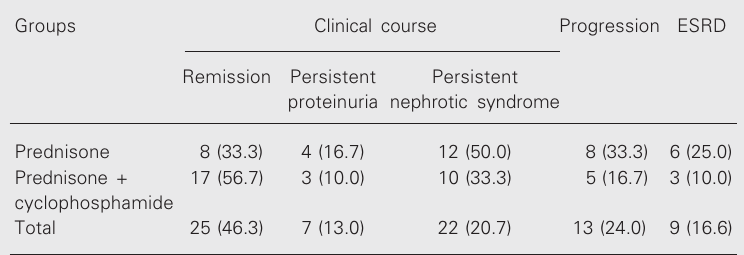
Table 5. Clinical course of patients with nephrotic syndrome in the two treatment groups. Groups